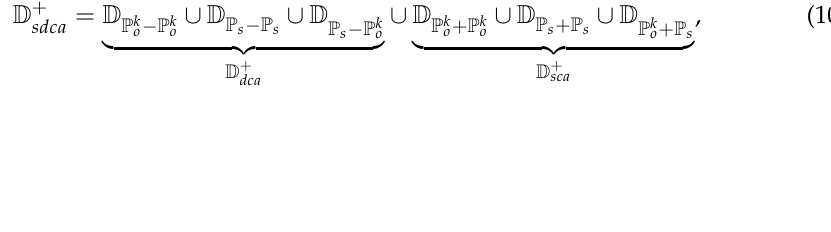
Figure 2. An example of k- level extended array with Definition 7 ( Spatial Efficiency ): By extracting the positive parts of uniform DOF and the whole DOF in the sum-difference coarray, referred to as uDOF + and DOF + , respectively, the spatial efficiency of a sparse array is defined as the ratio of uDOF + to DOF + , i.e., η = uDOF + / DOF +